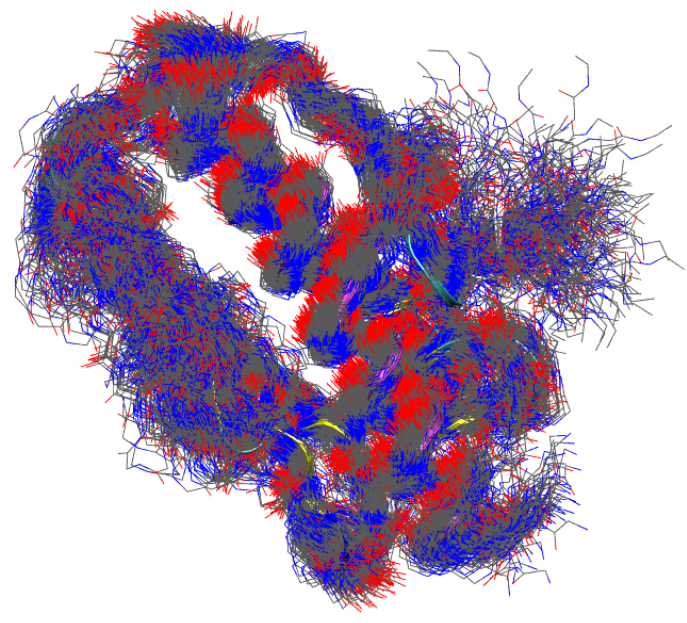
Figure 6. Structures of FXN, WT sequence, with RMSD1 < 3.3 Å. 254 structures uniformly sampled within the 254,298 collected are displayed. Only non-hydrogen backbone atoms are displayed for clarity. The drawing is made in the same protein orientation as in Figure 1. The drawing of 1EKG structure is made using